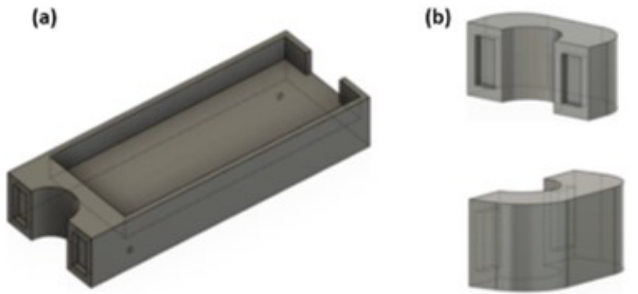
Figure 3. The CAD design of the second version of the mechanical support. ( a ) The housing for the electronic board. ( b ) The connection part for the positioning of the device along the EndoWrist